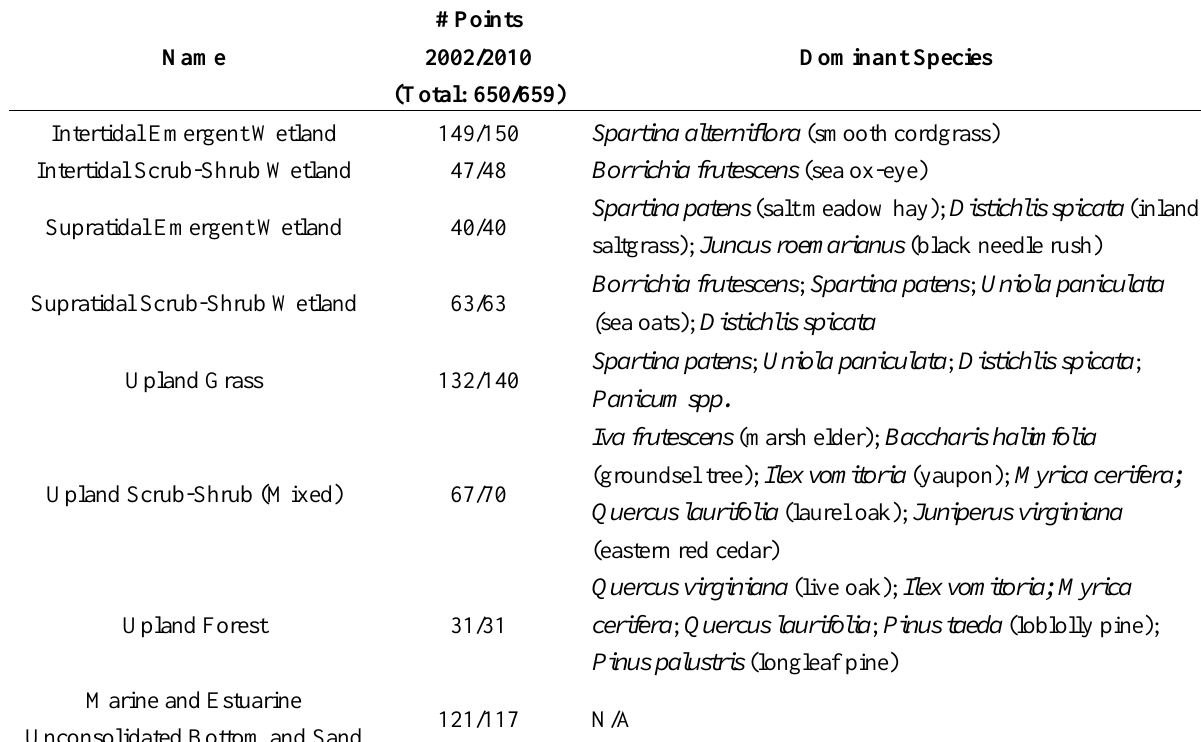
Table 2. Habitat Classification Scheme and Number of Ground Reference Points (adapted from